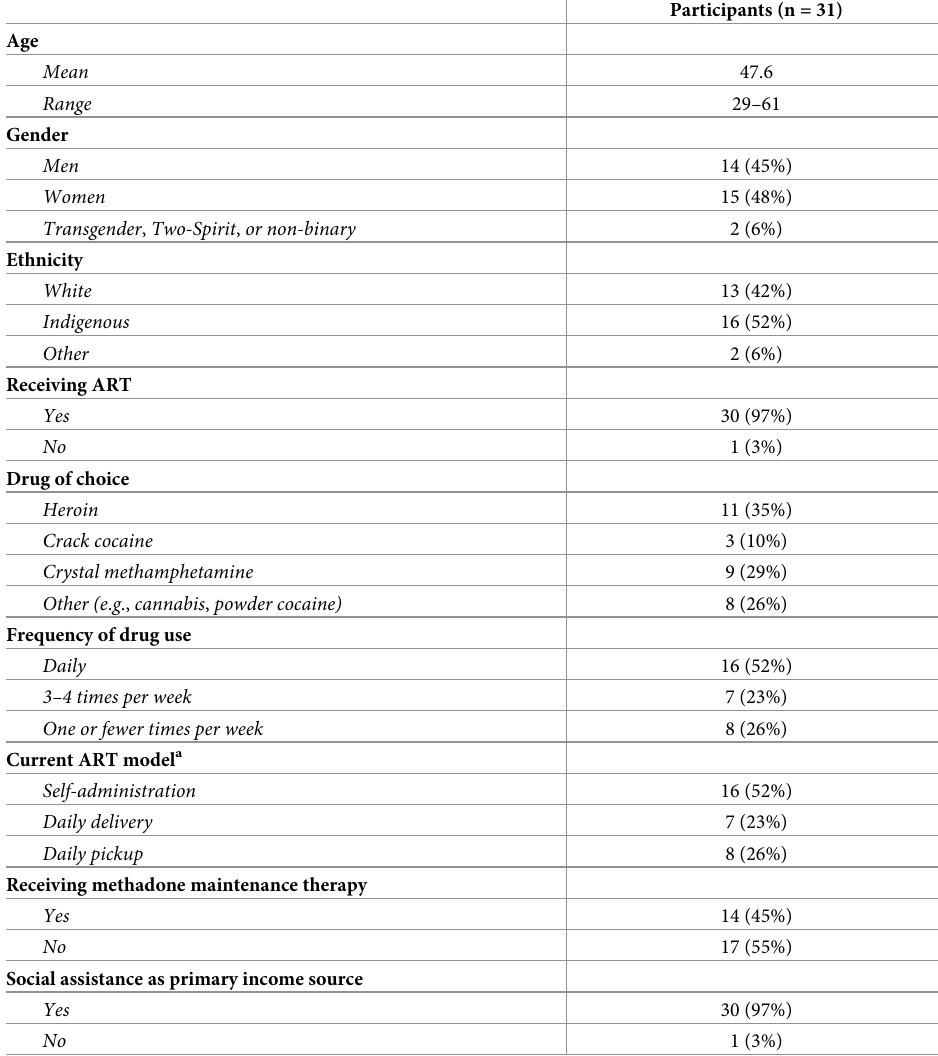
Table 1. Participant